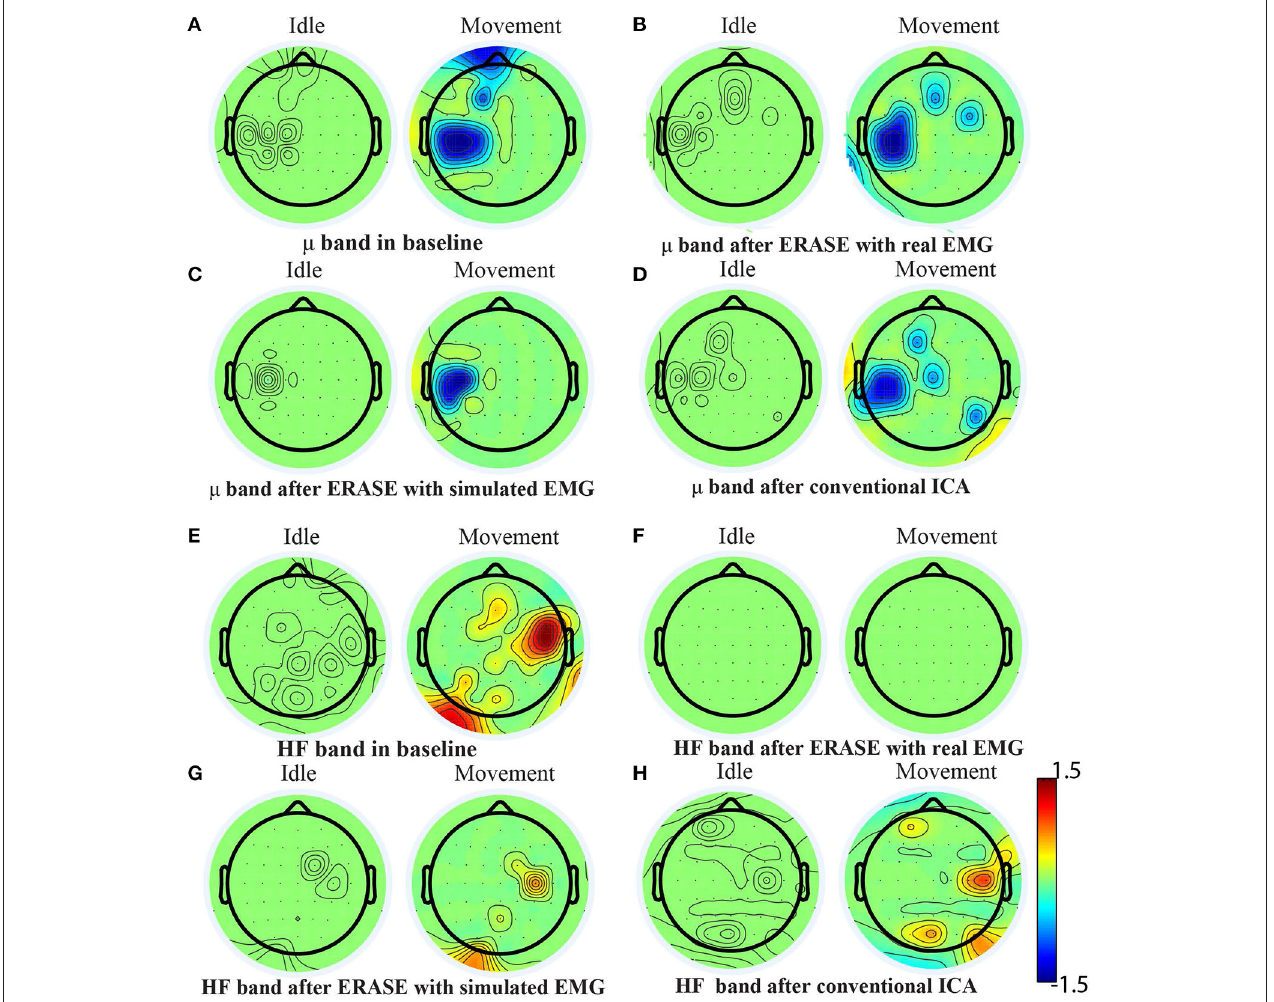
FIGURE 5 | Brain topography maps for Subject 1 displaying the z-scored power of µ band and high-frequency band in different conditions [baseline, after ERASE with real EMG and with simulated EMG and after conventional ICA, (A–D) for µ band and (E–H) for high-frequency band] on the Subject 1. Channels whose z-scored power of µ /high-frequency band were not significantly different between idle and movement states (Wilcoxon rank-sum test) were nulled (values were set to zero). The significance threshold was P < 0.01 for µ band and P < 0.05 for high-frequency band.